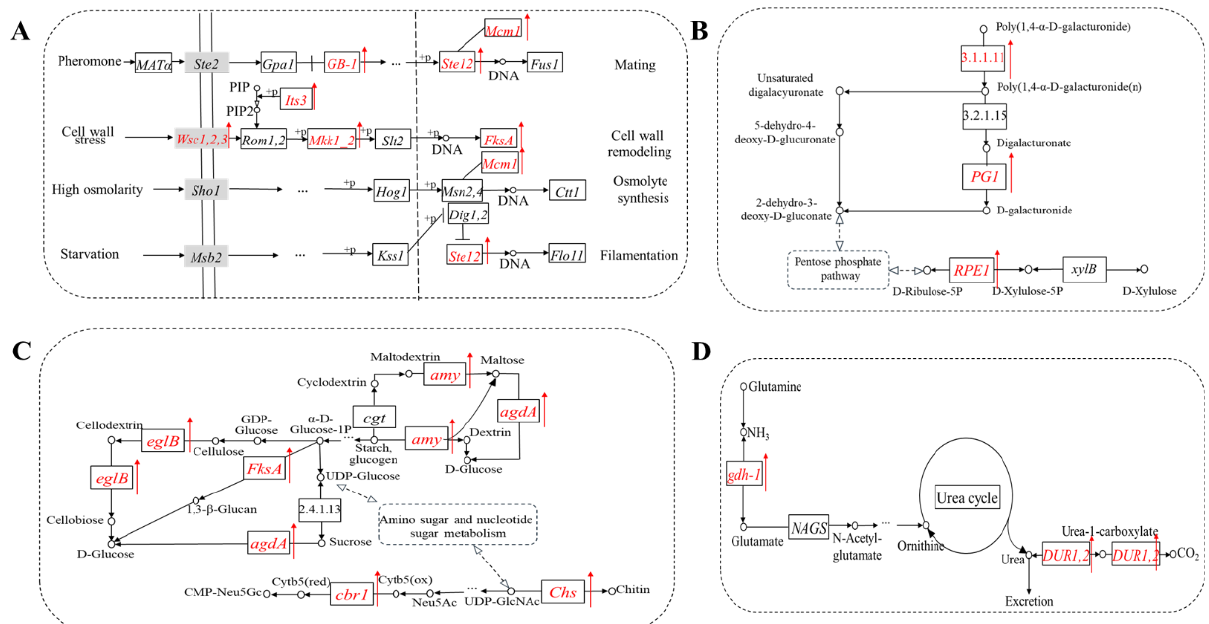
Figure 4. Several important KEGG pathways of DEGs in P. expansum . ( A ) MAPK signaling pathway; ( B ) Pentose and glucuronate interconversions & Pentose phosphate pathway; ( C ) Starch and sucrose metabolism & Amino sugar and nucleotide sugar metabolism; ( D ) Arginine biosynthesis. The red- colored gene names represent the up-regulated genes. Box represents gene (protein or mRNA), circle represents compound (generally metabolite).